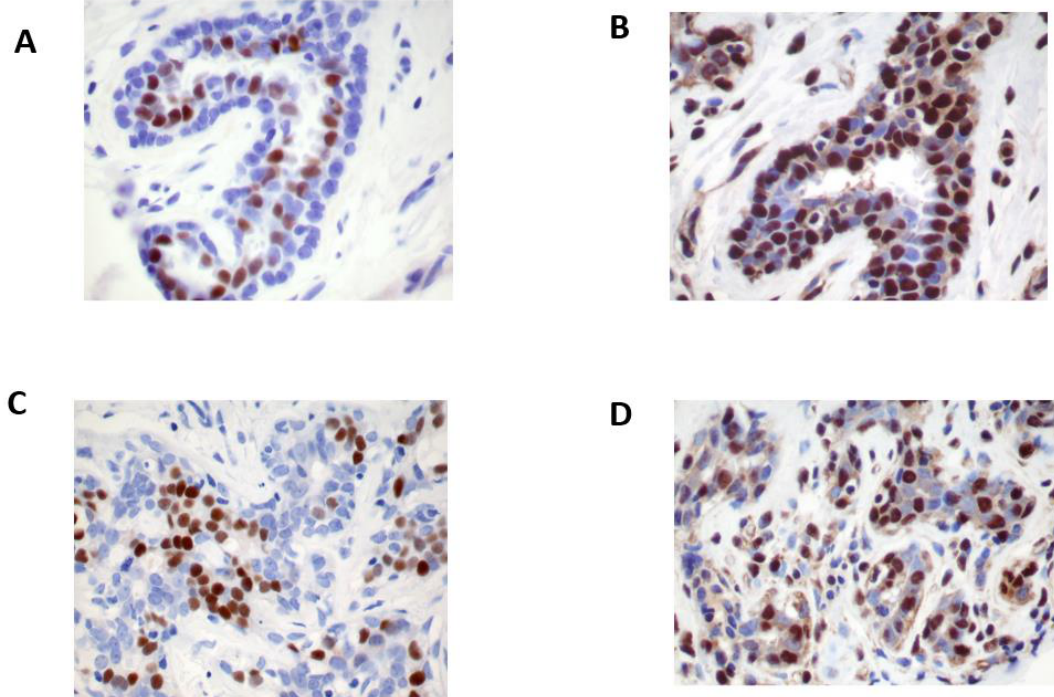
Figure 1. Immunohistochemistry stains of estrogen receptor (ER) β protein expression in normal and benign breast tissue. ER β expression ( A ) is expressed in the nuclei of benign epithelial cells and myoepithelial cells, stromal cells, and lymphocytes, whereas ER α ( B ) is expressed only in the nuclei of epithelial cells. The ER β reaction ( C ) is abundant and stronger than that of ER α ( D ) (immunohistochemistry stain using polyclonal ERβ1 (385p/AR385 -10R) antibody, original magnification ×20).